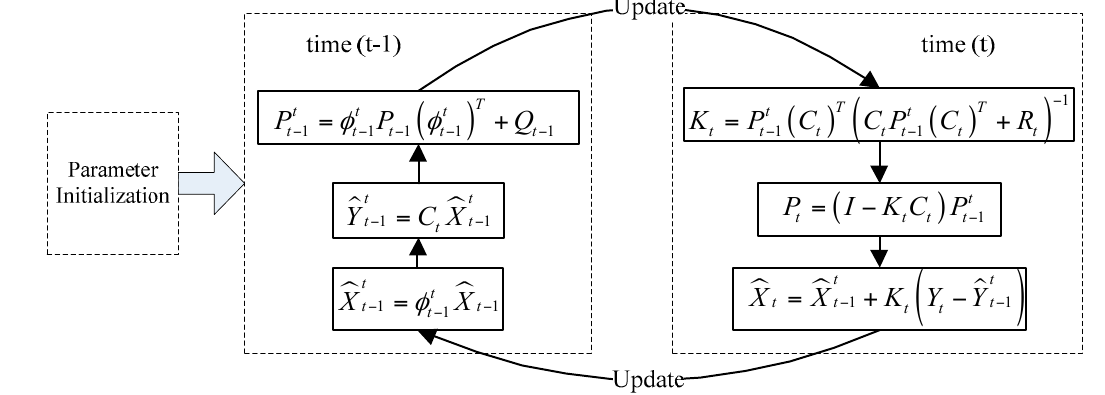
Figure 4. Kalman filtering scheme.